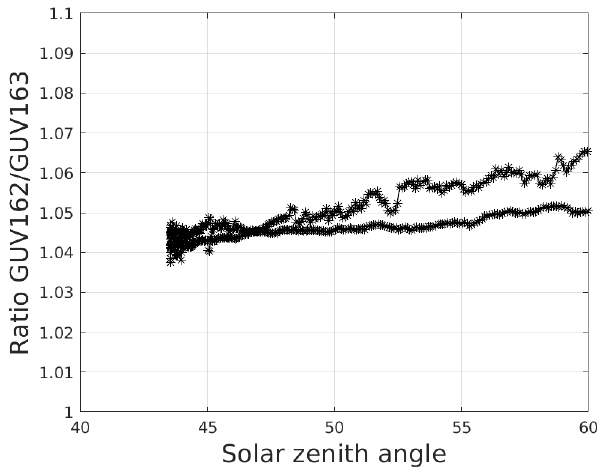
Figure 5. Ratio of the GUV UV index at Marambio on 25 Novem- ber